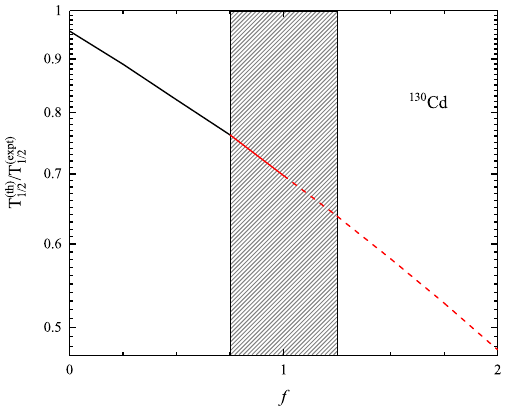
Figure 1. (Color online) The impact of dynamical neutron-proton pairing on the β -decay half-life of 130 Cd. Calculations performed with Skyrme EDF T43 [17]. Calculated half-life is normalized to the experimental value = 127 ± 2 ms [3]. The shaded area roughly relates to the soft SU(4)-limit; dashed line corresponds to the of T (expt) 1 / 2 range of the parameters, which had not been used in the presented